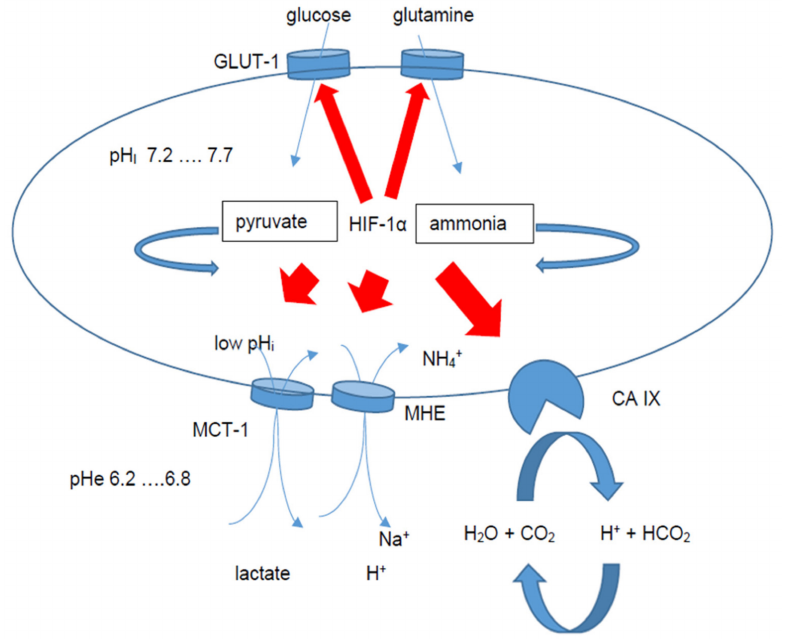
Figure 2. Metabolic adaptation to an increased energy consumption for enhanced tumor cell proliferation. HIF-1 α activates the glucose uptake and glutamine utilization. Toxic waste products, protons and ammonia induce an intracellular acidification accompanied by a decrease in pHi. As a consequence, HIF-1 α also induces an upregulation of NHEs and MCTs as well as CA IX. CA IX catalyzes the reaction of protons and hydrogencarbonate to H2O + CO2. The pHe is more acidic and acts as a driving force in the early EMT process. Red arrows show significant HIF-1 α -dependent processes and upregulated proteins. Blue arrows show catalyzing steps by enzymes as well as transport across the tumor cell